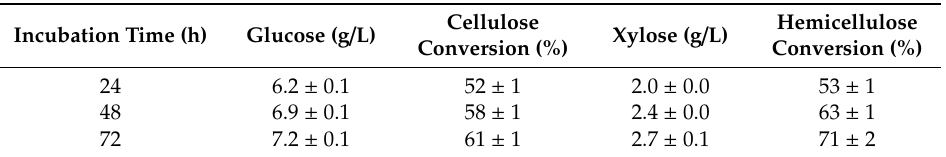
Table 1. E ffi ciency of the saccharification of chestnut shells performed with 0.6 g enzyme / g cellulose Table 1. Efficiency of the saccharification of chestnut shells performed with 0.6 g enzyme/g cellulose on biomass pretreated with aqueous ammonia at 5% ( w/v) loading. Efficiency was calculated with Equation (1) reported in on biomass pretreated with aqueous ammonia at 5% ( w / v ) loading. E ffi ciency was calculated with the materials and methods section. Equation (1) reported in the materials and methods section.